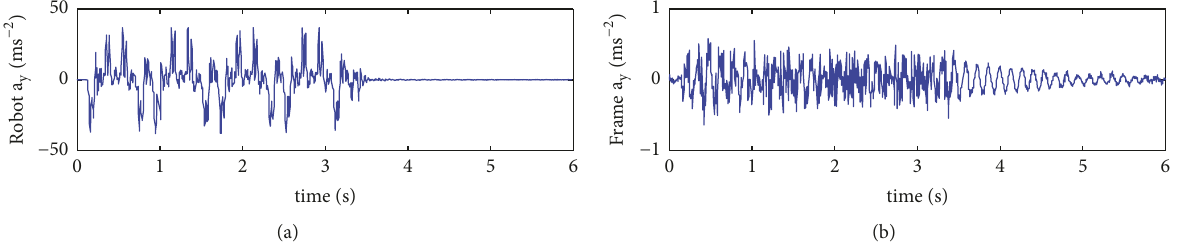
Figure 11: Typical vibration signals recorded by the IMU sensors. (a) Acceleration of moving platform along Y-axis; (b) frame vibration along Y-axis.